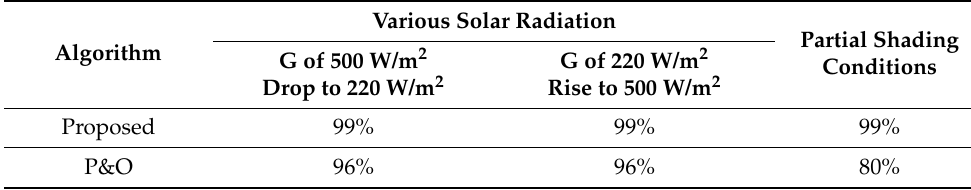
Table 1. Comparison efficiency of the proposed and P&O algorithm under various solar radiation and partial shading